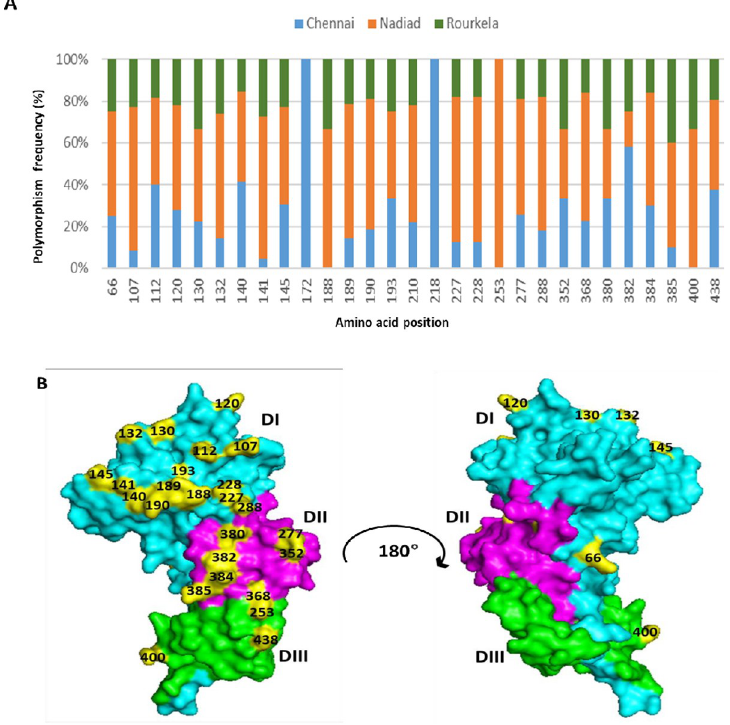
Fig 2. Frequency and location of polymorphic sites found in Pv AMA1 from Indian isolates. (A) The frequency of amino acid polymorphism at study sites Chennai, Nadiad and Rourkela are represented in blue, orange and green respectively. ( B) Based on the Pv AMA1 crystal structure (PDB ID: 1W81) Domain I, II and III are colored in cyan, magenta and green respectively. Polymorphic amino acid residues at each domain are numbered and colored in